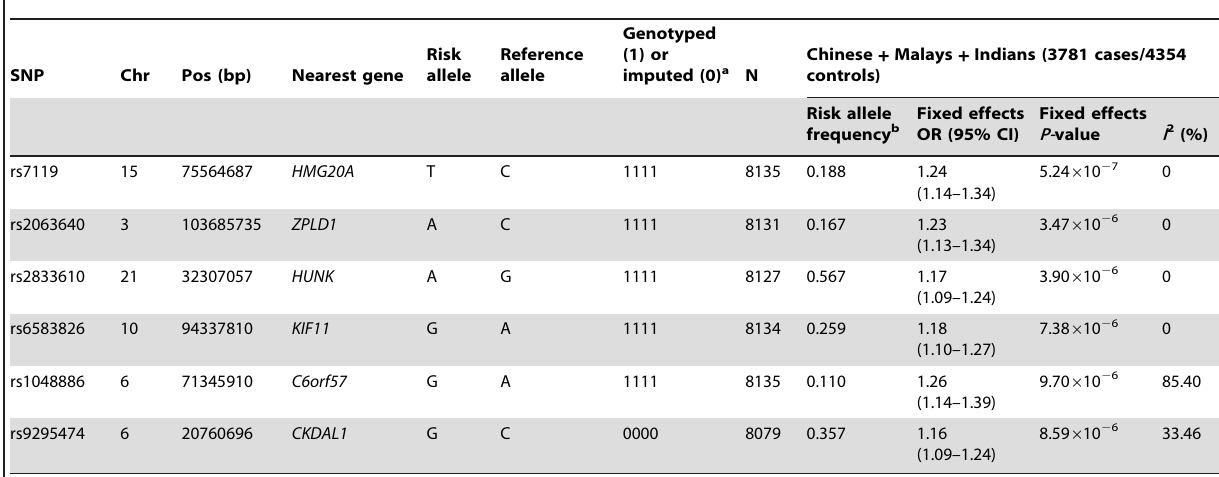
Table 2. Statistical evidence of the top regions (defined as P , 10 2 5 ) that emerged from the fixed-effects meta-analysis of the GWAS results across Chinese, Malays, and Asian Indians, with information on whether each SNP is a directly observed genotype (1) or is imputed